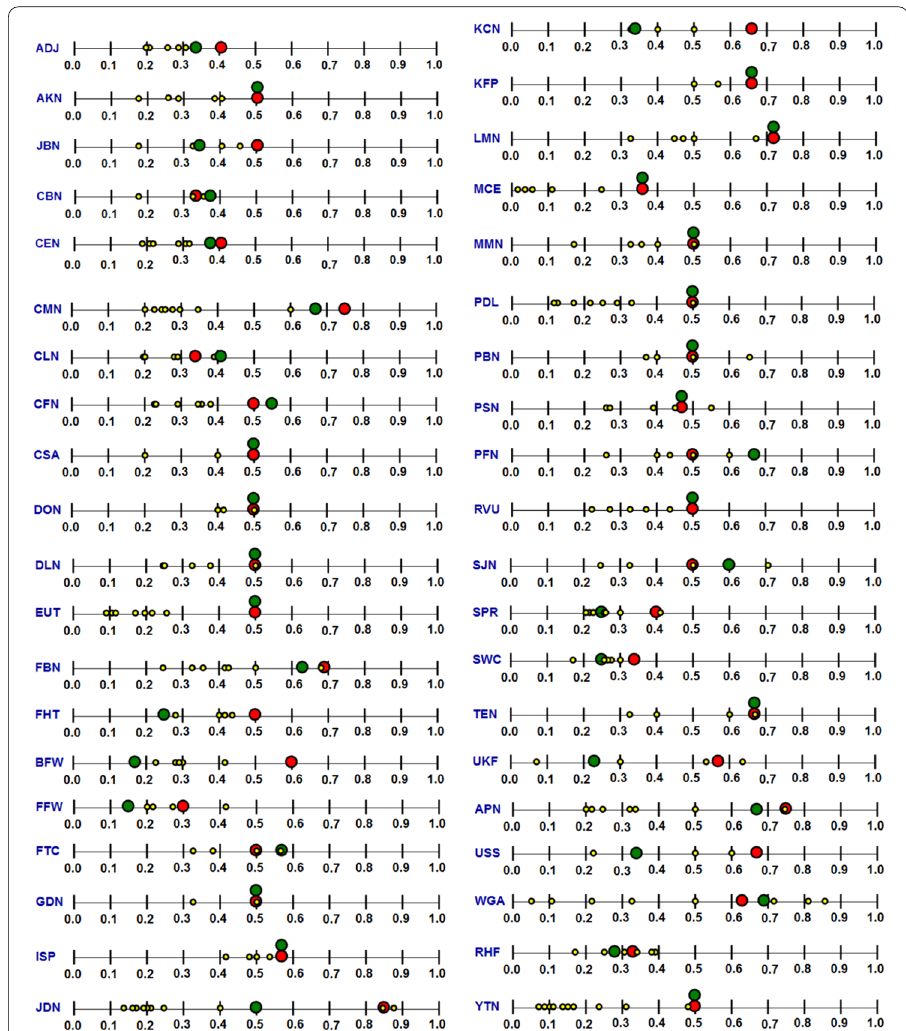
Fig. 7 Comparison of the intra-cluster densities of the clusters (determined using the Louvain algorithm) of the real-world networks with the CBI(DEG) and CBI(BWC)